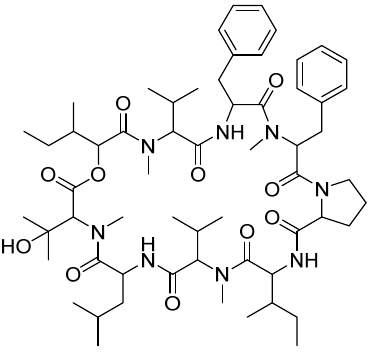
Figure 9. The chemical structure of Aureobasidin